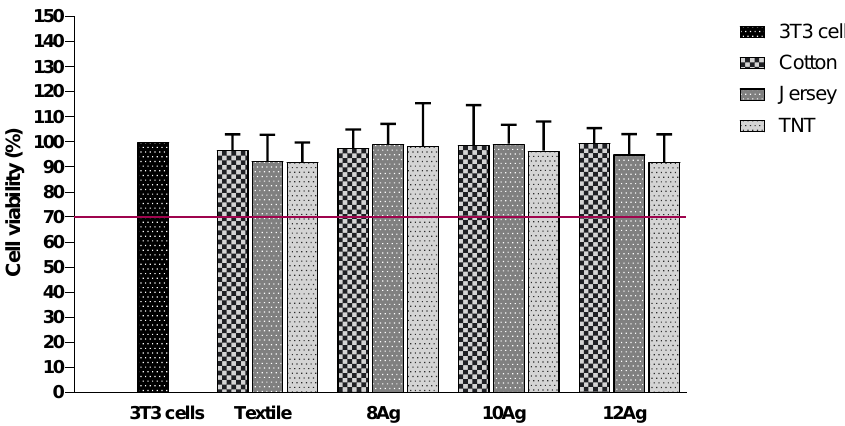
Figure 2. Cell viability evaluated by indirect contact test, after 168 h of AS contact with uncoated and coated fabrics. 3T3 cells are the control. The red line indicates the limit percentage of viable cells at which the material, in this case the coating, is considered non-toxic.